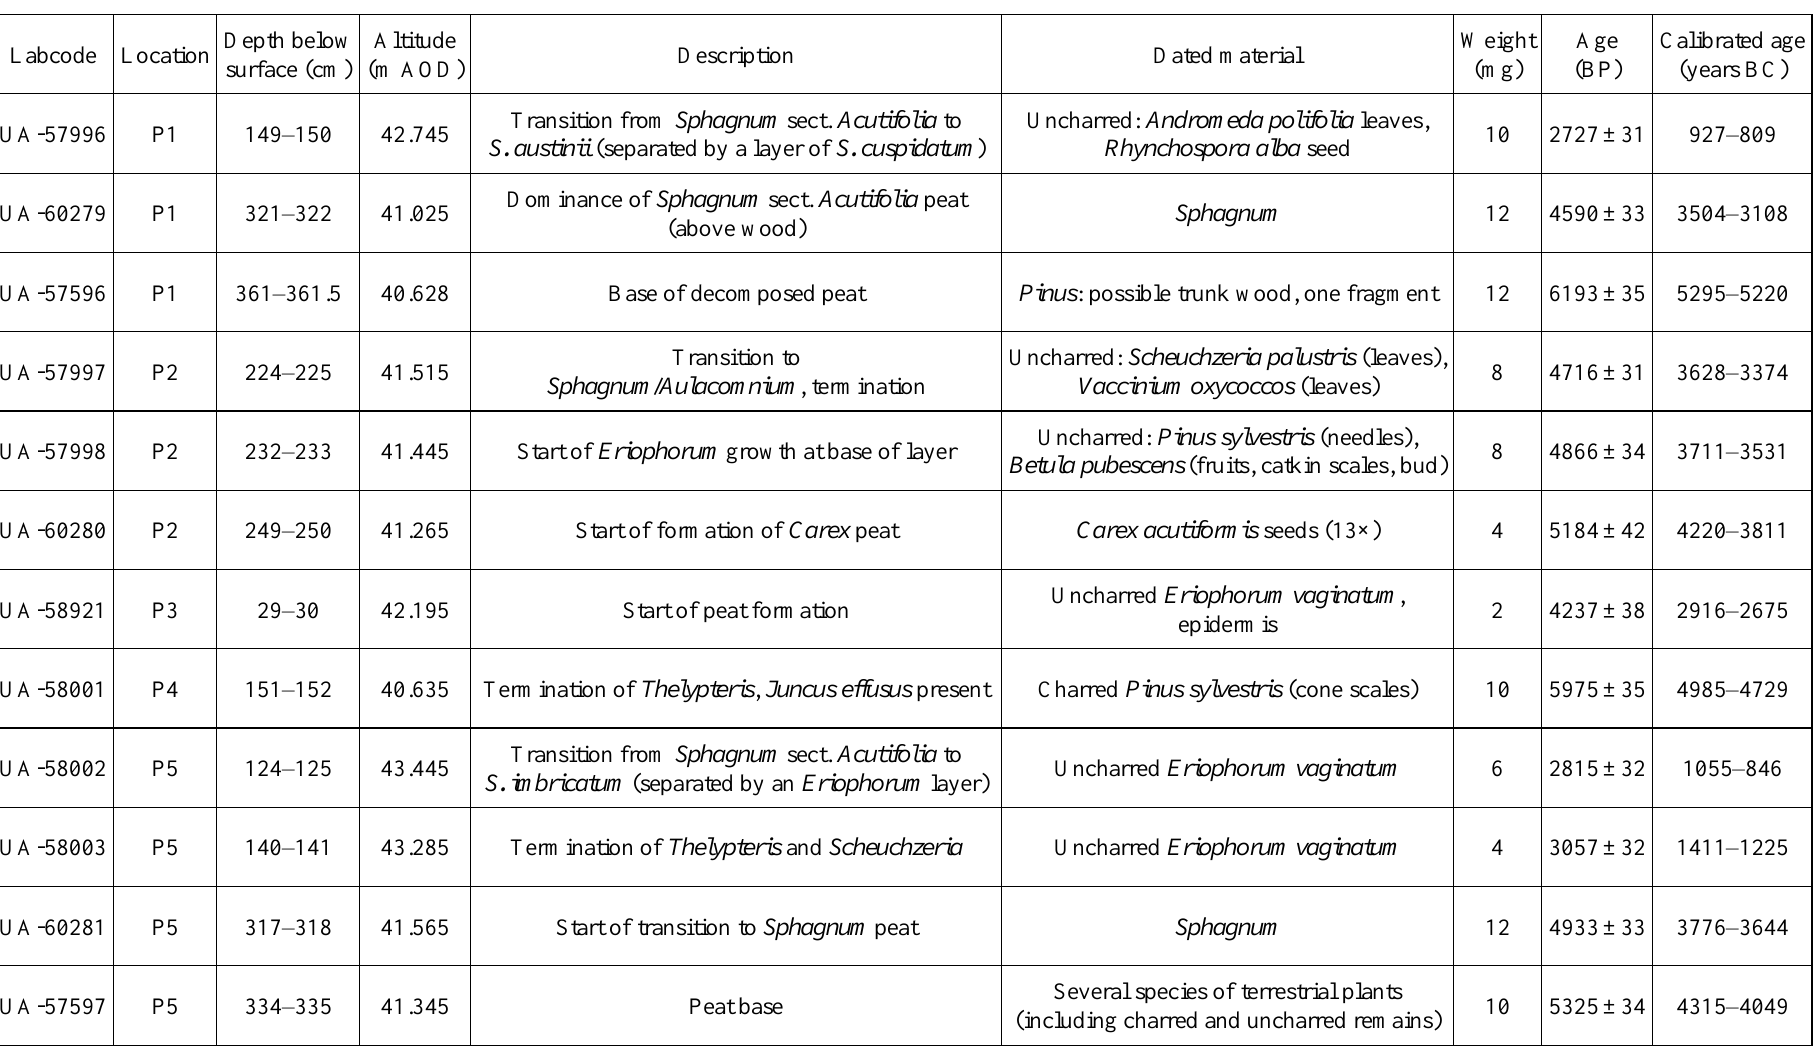
Table 2. Radiocarbon dates for strata from the Aamsveen. Labcode Location